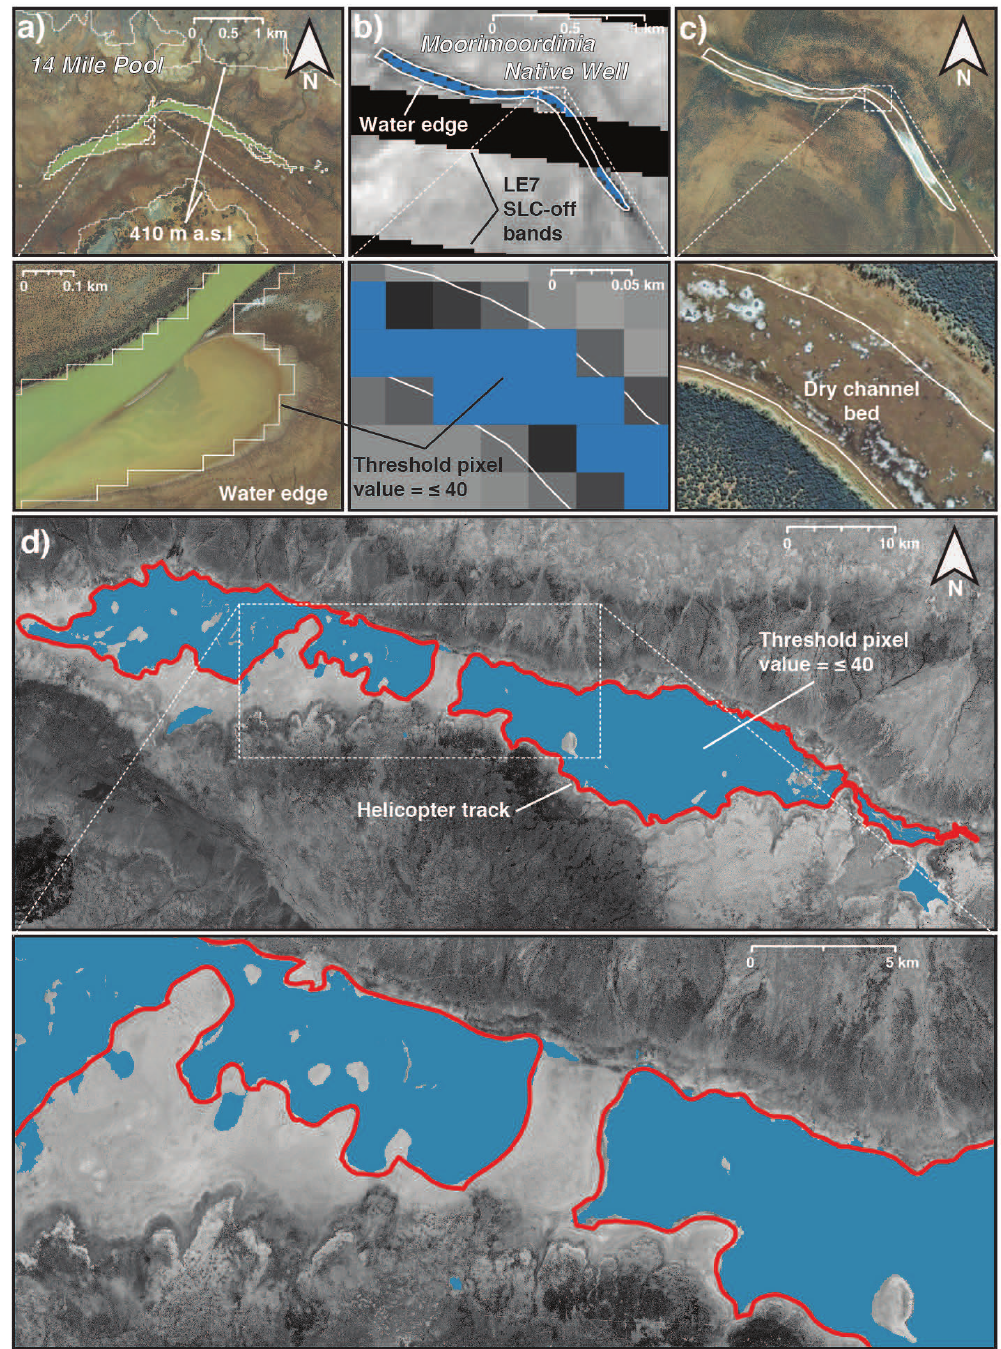
Figure A1. Validation and ground-truthing of standing water on the Fortescue Marsh, including (a) standing water on the 14 Mile Pool extracted from Level 1T Landsat image (July 2010; solid white line shows threshold pixel value ≤ 40; LT5; USGS) and close-up against a 40cm resolution orthophoto (July 2010); delineation by GPS route tracking while walking along the water edge (1–2m distance from stand- ing water; solid white line) and close up against (b) a Level 1T Landsat image of Moorimoordinia Native Well (November 2012; blue fill shows threshold pixel value ≤ 40; LE7-SLC-off, USGS) and (c) a RGB image showing the extent of the dry channel bed (December 2006; SPOT-5); (d) delineation of standing water by GPS route tracking during a low-altitude helicopter survey along the water plume of the Fortescue Marsh (12 February 2012; solid red line) and close up against standing water extracted from Level 1T Landsat image (14 Febru- ary 2011; blue fill shows threshold pixel value ≤ 40; corrected LE7-SLC-off; USGS), overlain on a 2.5m resolution RGB image taken during dry season (December 2006;